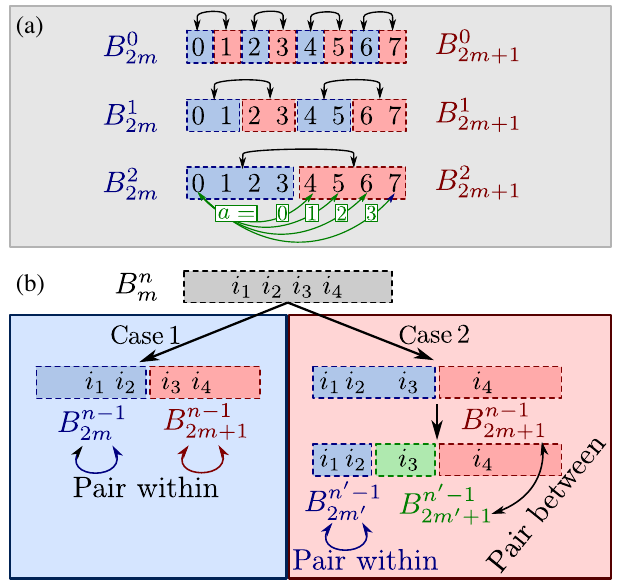
FIG. 3. Schematic of the fermionic partition strategy for generating cliques that contain all local fermionic